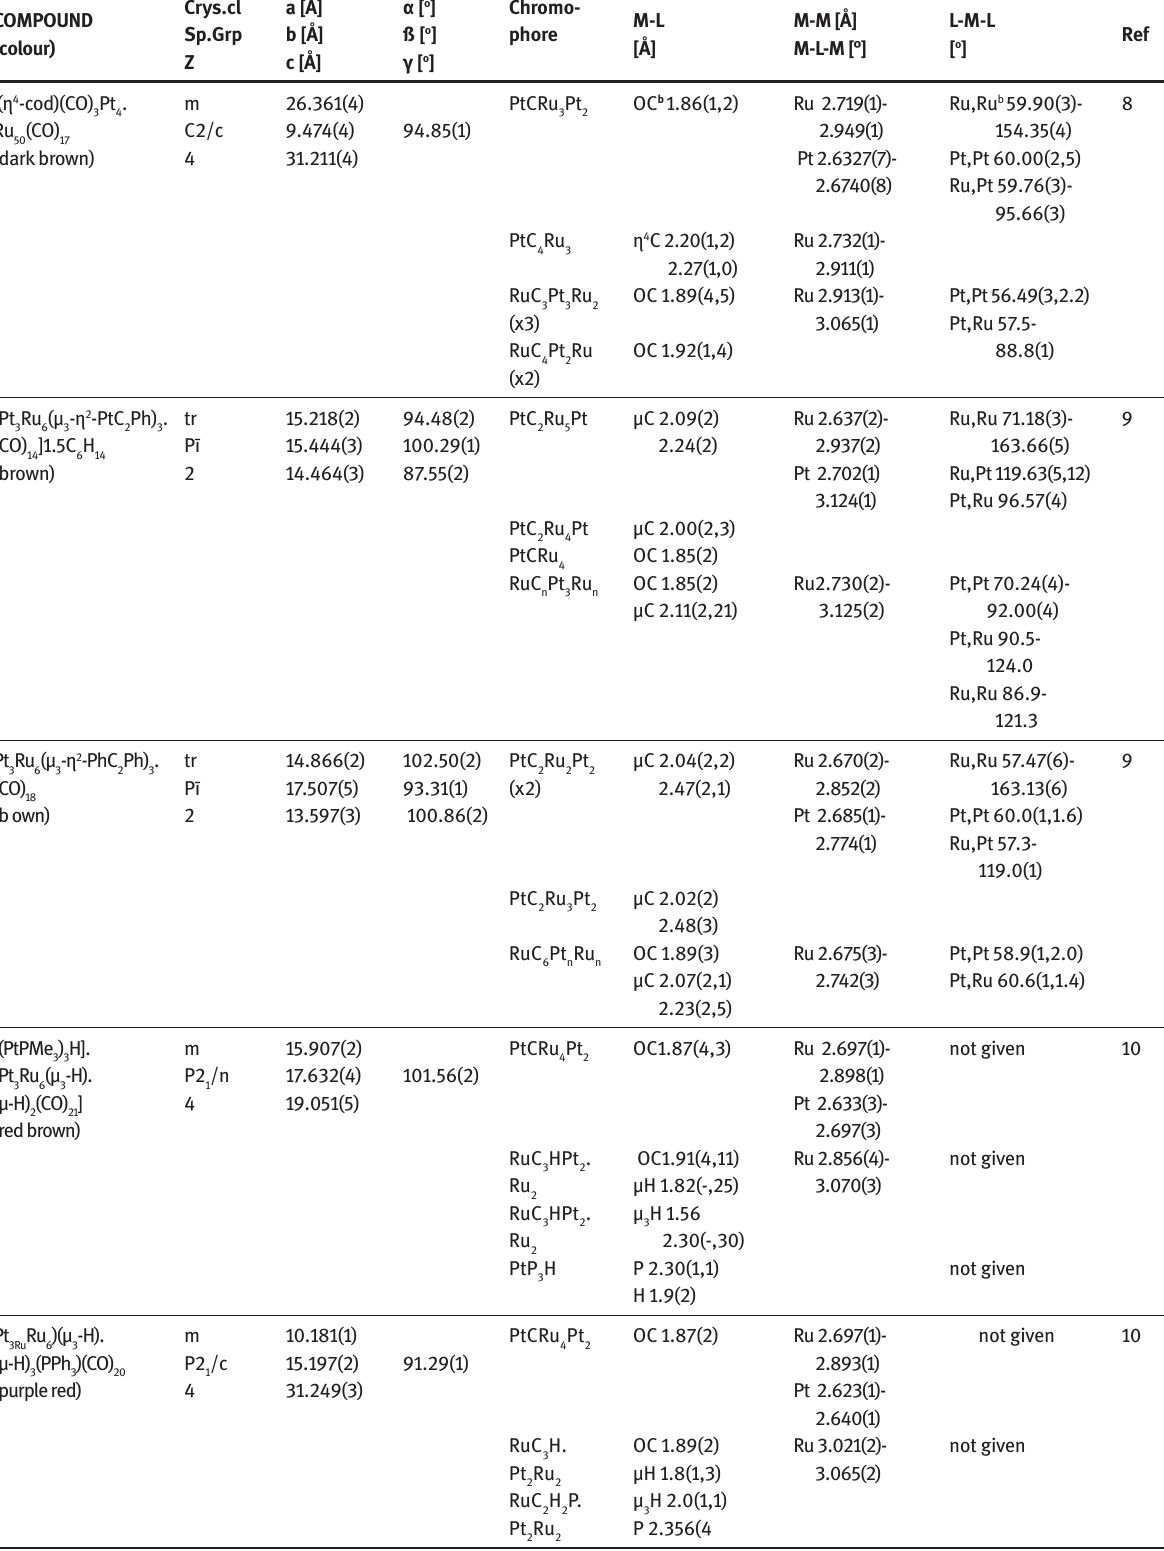
Table 1: Crystallographic and structural data for heterononanuclear platinum clusters a .